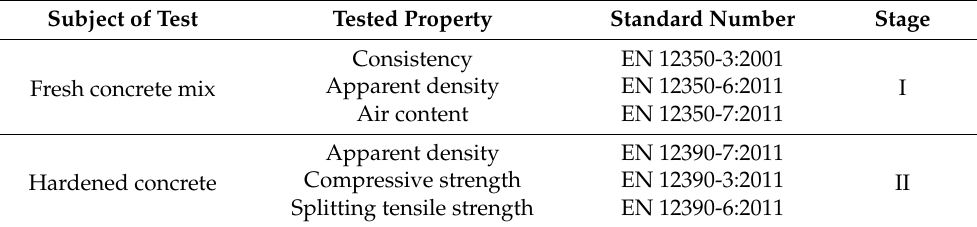
Table 2. Composition of concrete mixes used in the experiment.